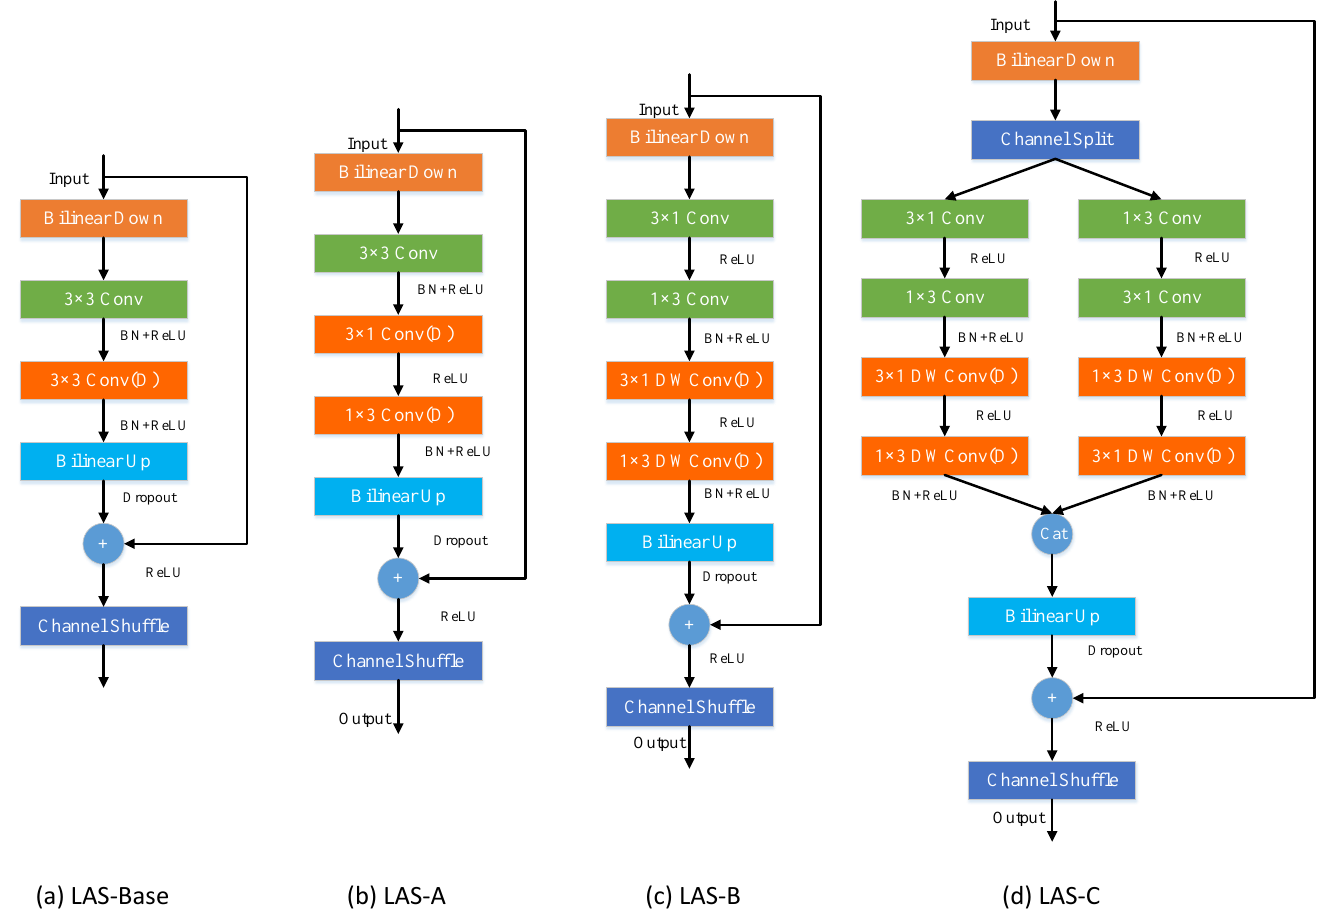
Figure 3. Detailed architecture of LAS